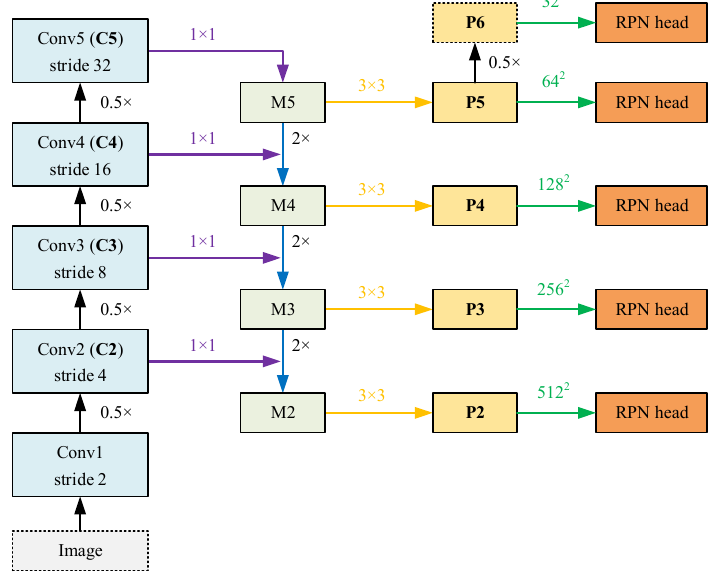
Figure 5. The process of feature extraction, feature merging, and proposal generation.